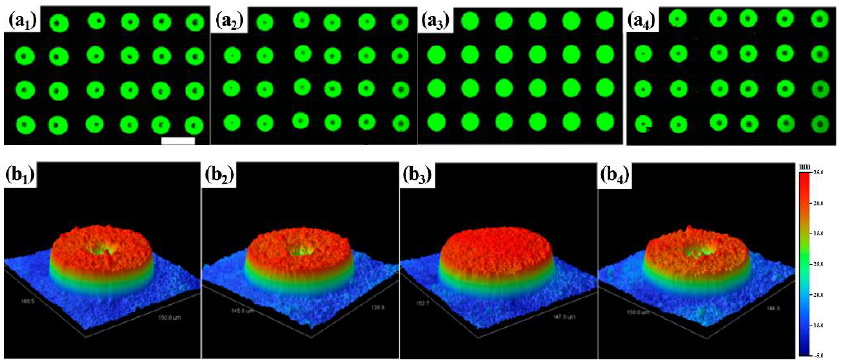
Figure 5. ( a ) Fluorescence microscope images of QD dot films (scale bar is 200 µm). The precursor inks have oDBC of 0 ( a 1 ), 10 ( a 2 ), 20 ( a 3 ), and 30% ( a 4 ) by volume, respectively. ( b 1 – b 4 ) 3D morphology images of ( a 1 – a 4 ), respectively. Reproduced with permission [54]. Copyright 2019, American Chemical Society.